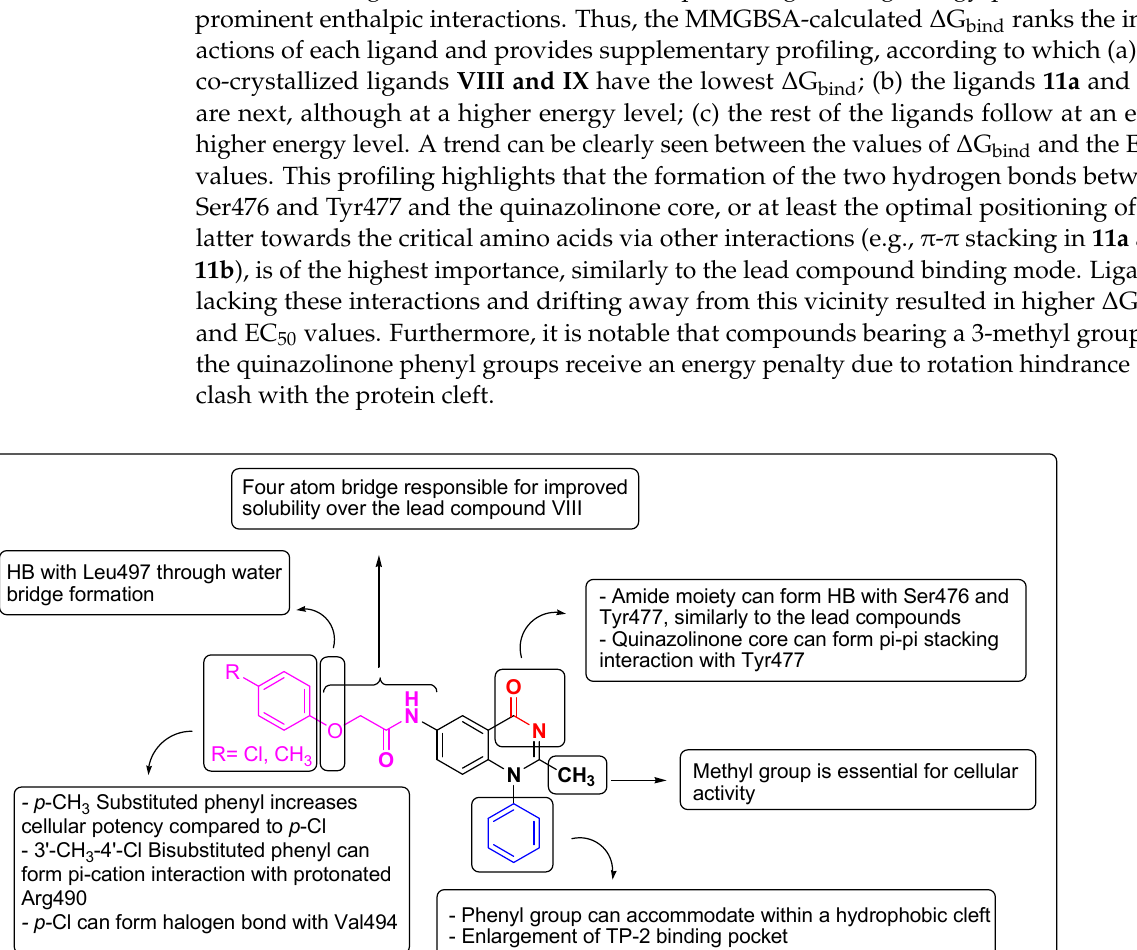
Table 4. Calculated lipophilic and solubility parameters for the synthesized compounds and the ligand compound IX.